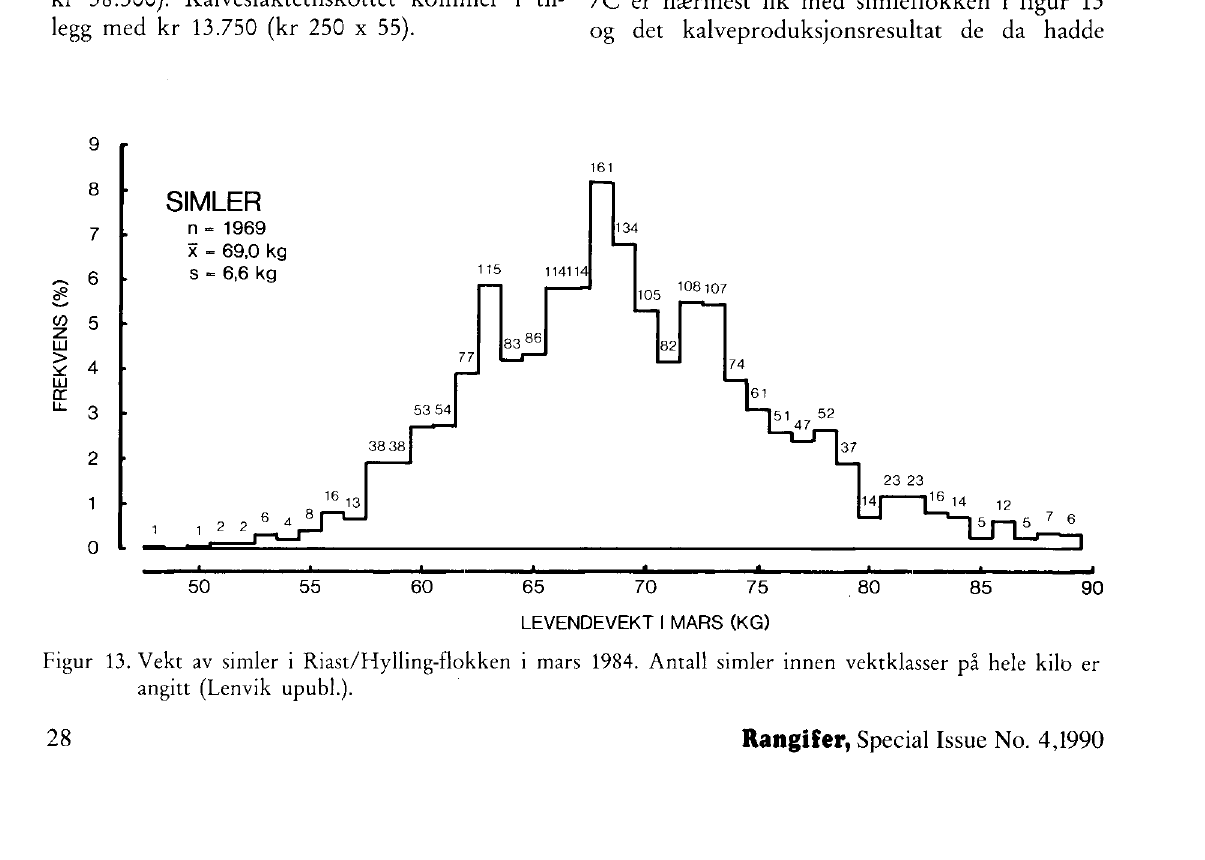
Figur 13. Vekt av simler i Riast/Hylling-flokken i mars 1984. Antall simler innen vektklasser på hele kilo er angitt (Lenvik